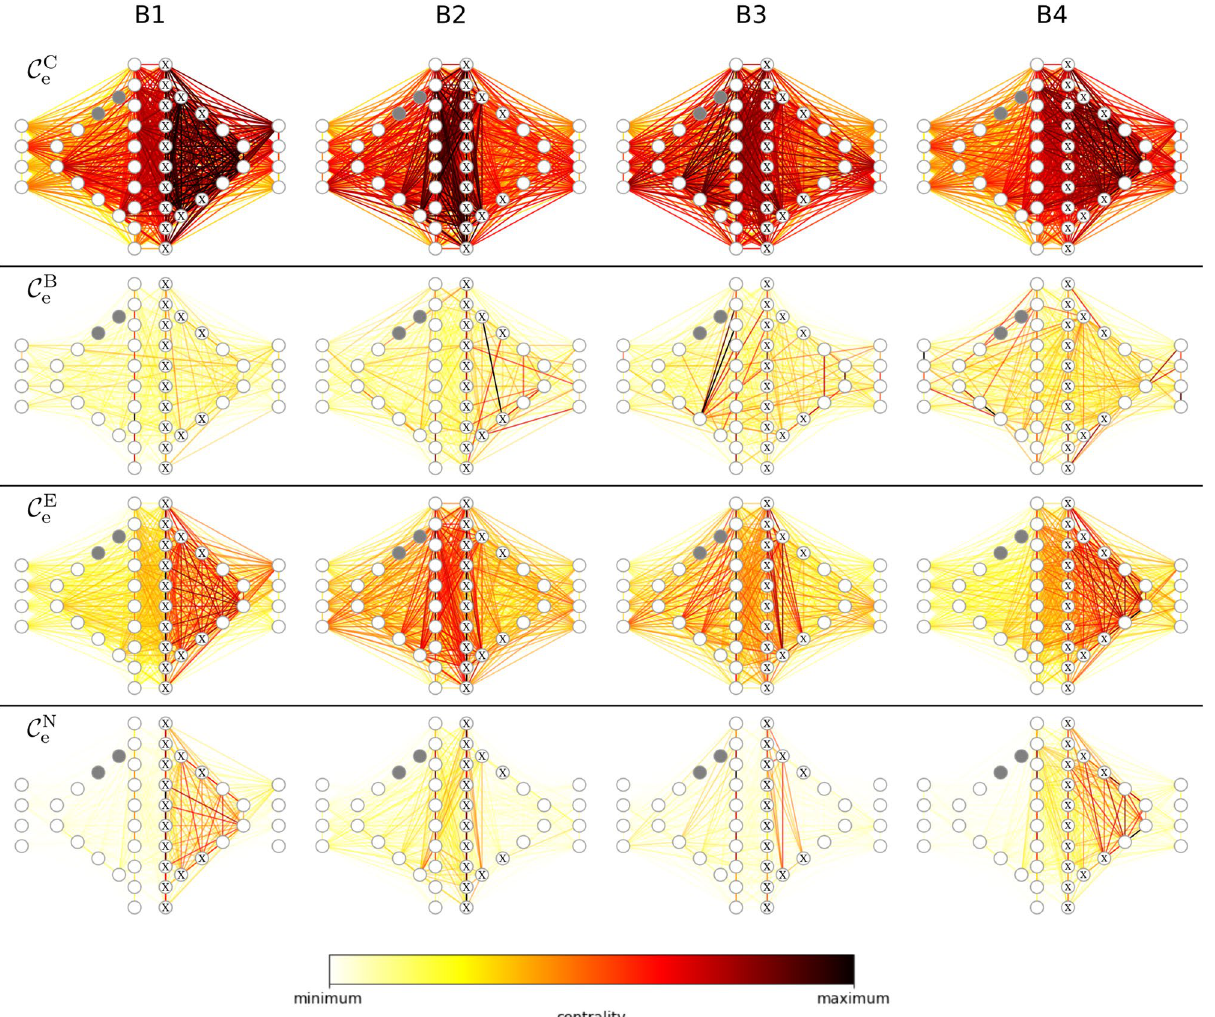
Figure 6. Key interactions in evolving functional brain networks during an epileptic seizure. Interactions identified with different edge centrality concepts (edge closeness centrality C C e ; edge eigenvector centrality C E C B C N e ; edge betweenness centrality e ; nearest-neighbor edge centrality e ). Vertices and edges projected onto a schematics of implanted sensors shown in Fig. 5. Edge color encodes normalized mean centrality values for each block (B1, . . . , B4). Vertices marked with ‘x’ record from the clinically defined seizure onset zone, and grey- colored vertices indicate EEG reference sensors (not included in